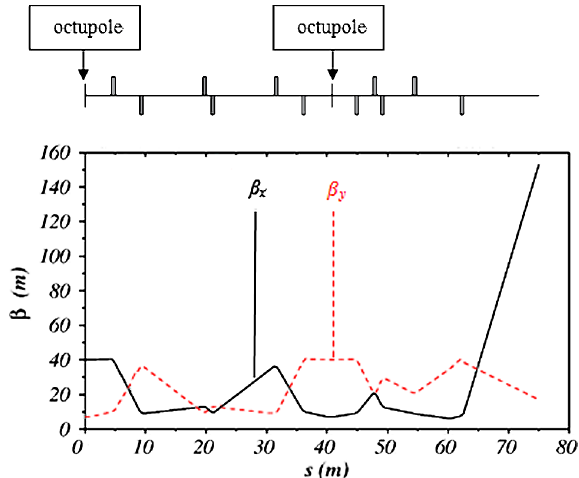
FIG. 7. Beam envelop.